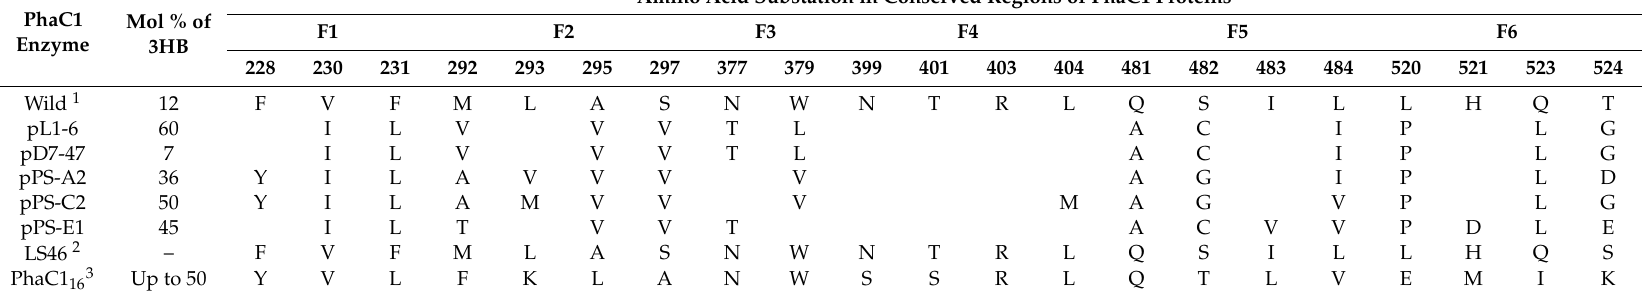
LS46 2 * Modified from [40]; Numbering of amino acids in PhaC1 is based on Sheu and Lee [39]; 1 P. putida Gpo1 PhaC1 PpGpo1 (WP_037049875.1); 2 P. putida LS46 PhaC1 PpLS46 (EMR48251),